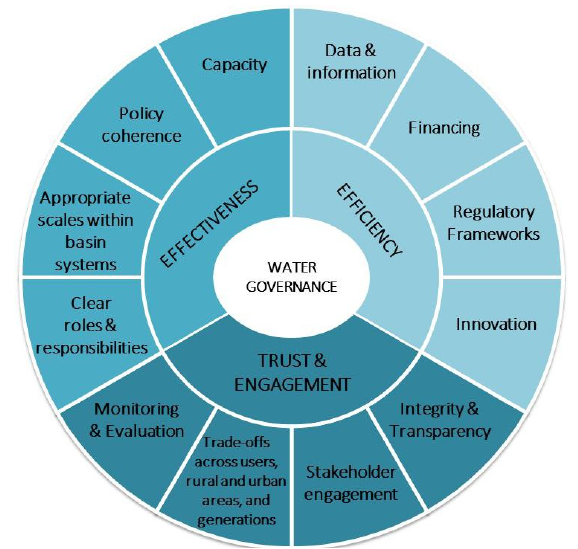
Figure 1. The Organisation for Economic Co-operation and Development (OECD) Principles on Water Governance. Source: OECD (2015), OECD Principles on Water Governance [5].